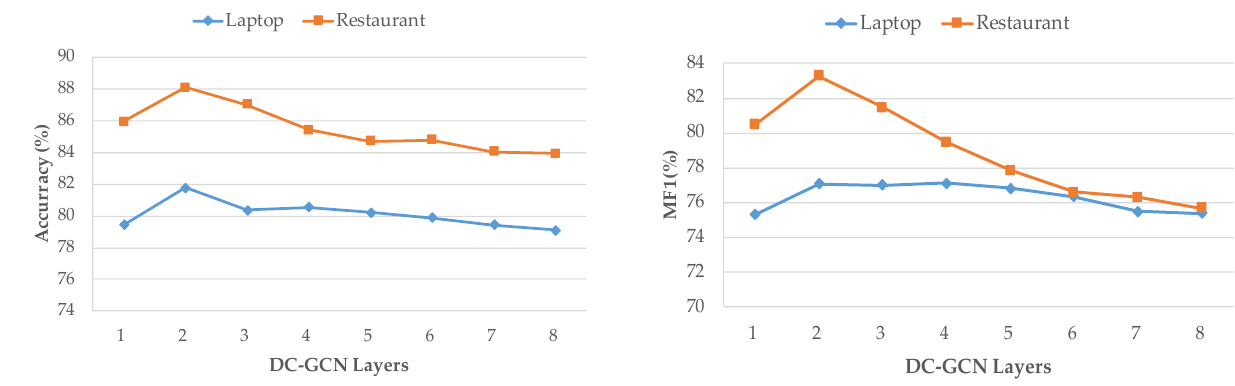
Figure 5. Effect of the number of DC-GCN layers.